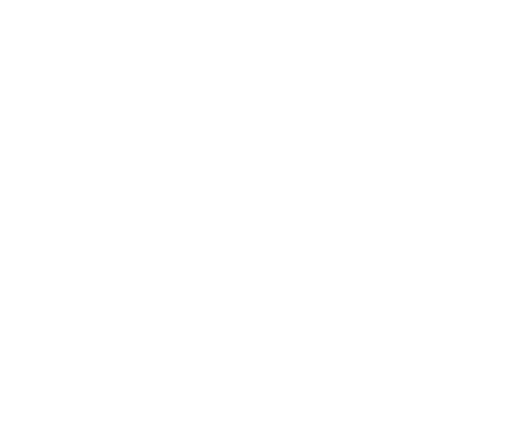
Figure 13. Correlations between changes in body fat content and changes in serum anti-TPO levels in the women studied (between initial visit V1 and final visit V3.